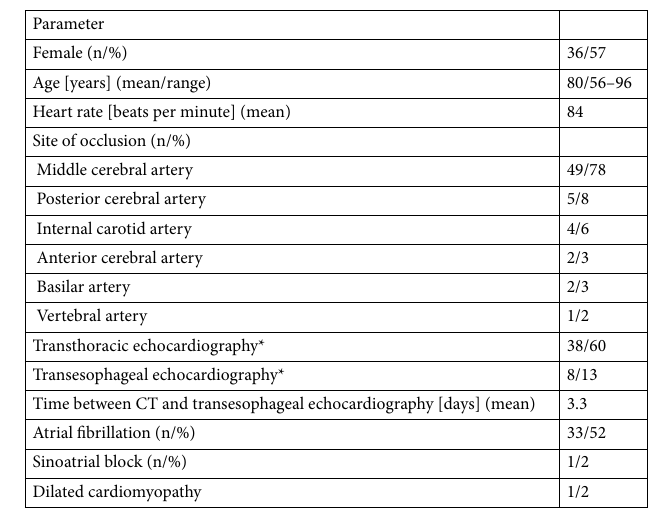
Table 1. Patients’ characteristics. *Within 10 days after cardiac